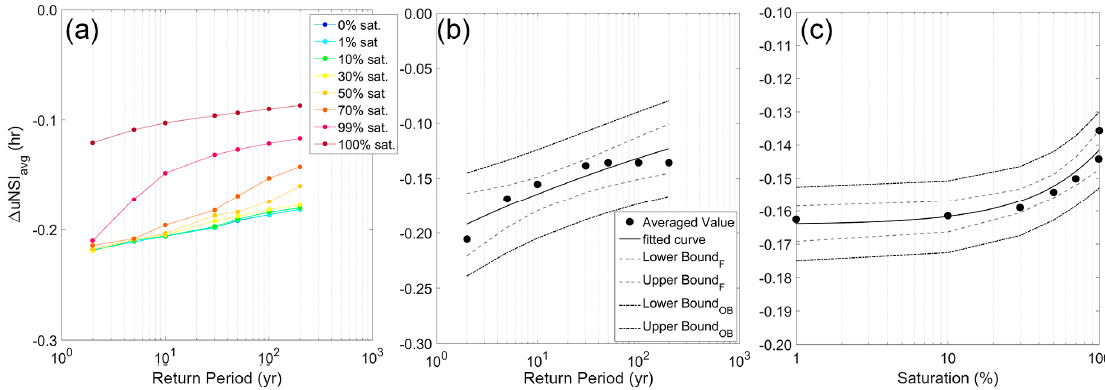
Figure 7. Average difference in uNSI between 2010 and 1982. A negative sign indicates a faster response of the network in 2010. Differences in uNSI (evaluated considering all hyetograph types) as a function of the Return period ( a ) averaged for each of the considered antecedent soil moisture condition (0 to 100% saturation), and ( b ) averaged considering all saturation conditions. ( c ) Average difference between uNSI considering all hyetograph types and return periods as a function of the antecedent soil moisture condition (saturation). In ( b ) and ( c ) different prediction bounds are shown: Bound OB describes y n+1 (x), for all x, while Bound F shows the fitted equation for all x. Note that the intervals associated with a new observation (OB) are wider than the fitted function (F) intervals because of the additional uncertainty in predicting a new response value (the curve plus random errors).